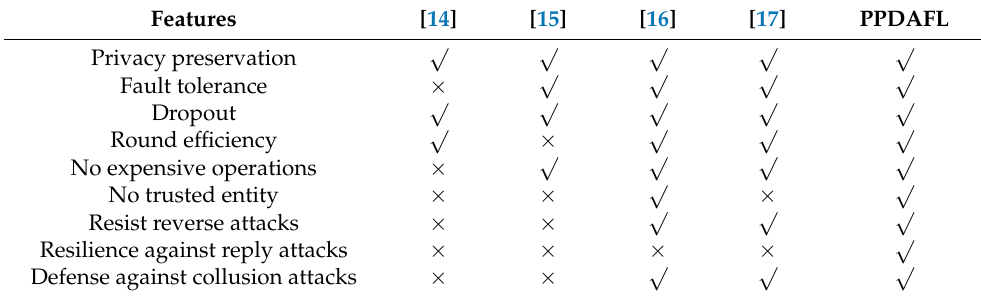
Table 2. Comparison of features between PPDAFL and other related